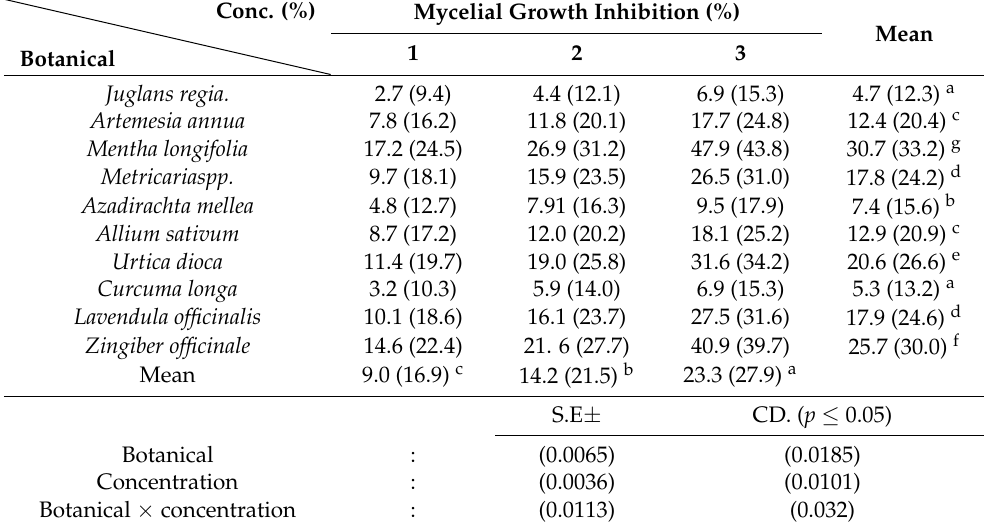
Table 3. Efficacy of botanicals against mycelial growth of Agaricus bisporus in vitro at concentrations between 1 and